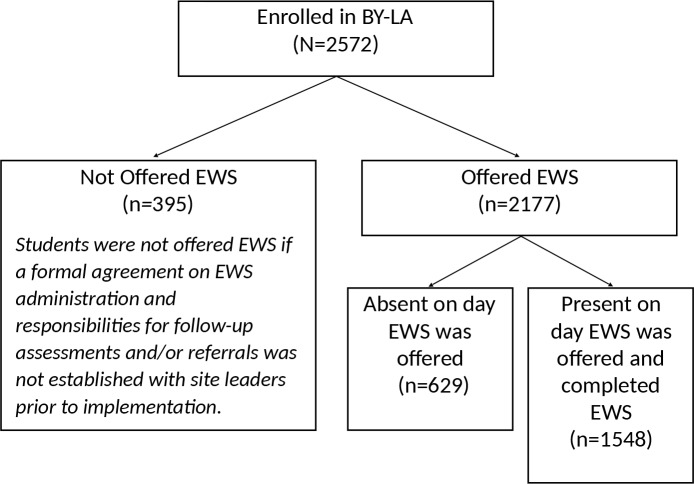
Consort diagram of BY-LA emotional wellness screener (EWS) completion.